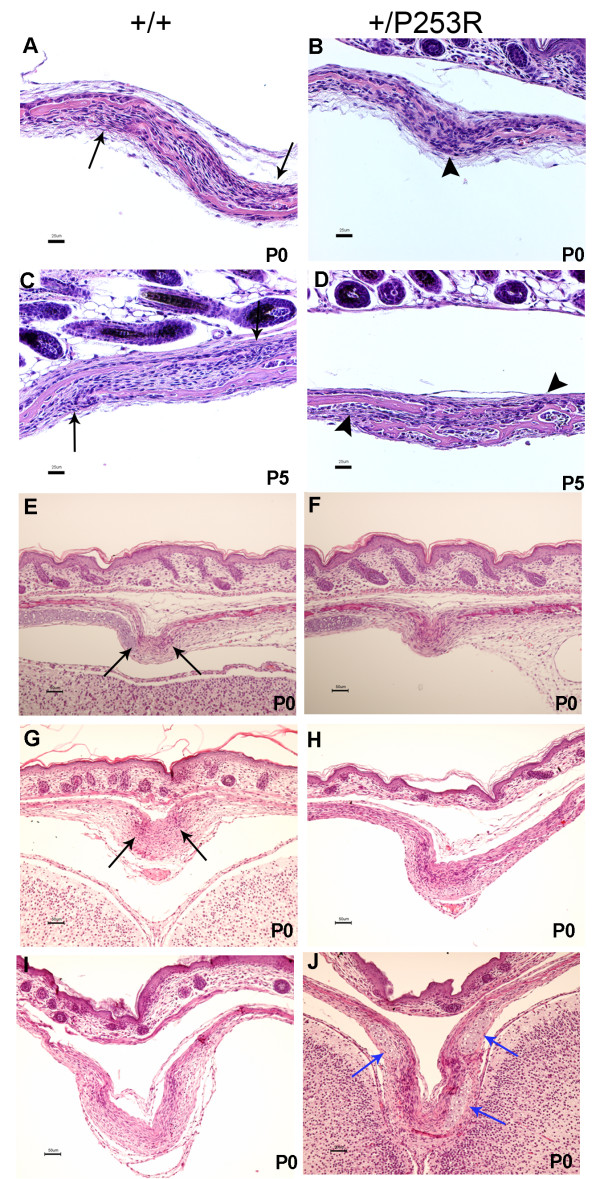
Histological analysis of the abnormal calvarial sutures in Fgfr2+/P253R mice. A-D) HE staining shows the abnormal development of the mutant coronal suture from P0 to P5 with presynostosis, disorganization of cells between the osteogenic fronts and osteoid deposition at P0 (A, B); and synostosis at P5 (C, D). E-H) HE staining shows the abnormal development of the mutant lambdoid (E, F) and sagittal suture (G, H) with proximate osteogenic fronts and cellular disorganization at P0. I, J) abnormal cartilage at the sagittal suture (blue arrows). Panels A, C, E, G and I are from littermate controls. Panels B, D, F, H and J are the corresponding regions in mutant mice. Black arrows, osteogenic fronts; arrowheads, presynostosis/synostosis. (Scale bars: A-D = 25 μm; E-J = 50 μm).